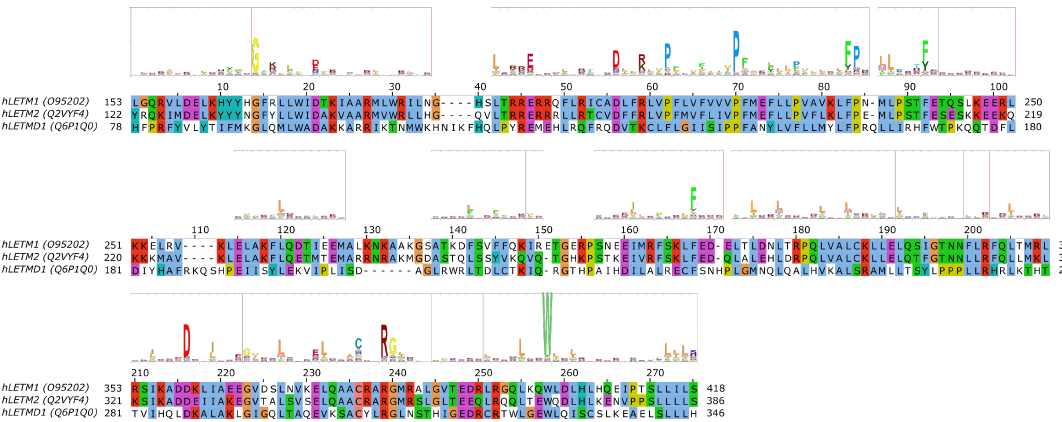
Figure 4. Sequence analysis of human LETM proteins (SLC55 family). HMM logo is shown over the alignment, based on the “LETM1” HMM model from Pfam (see text). Only the alignment region covered by the HMM model is shown. Certain non-conserved residue positions with ambiguous matches with the protein sequences have been removed from the HMM